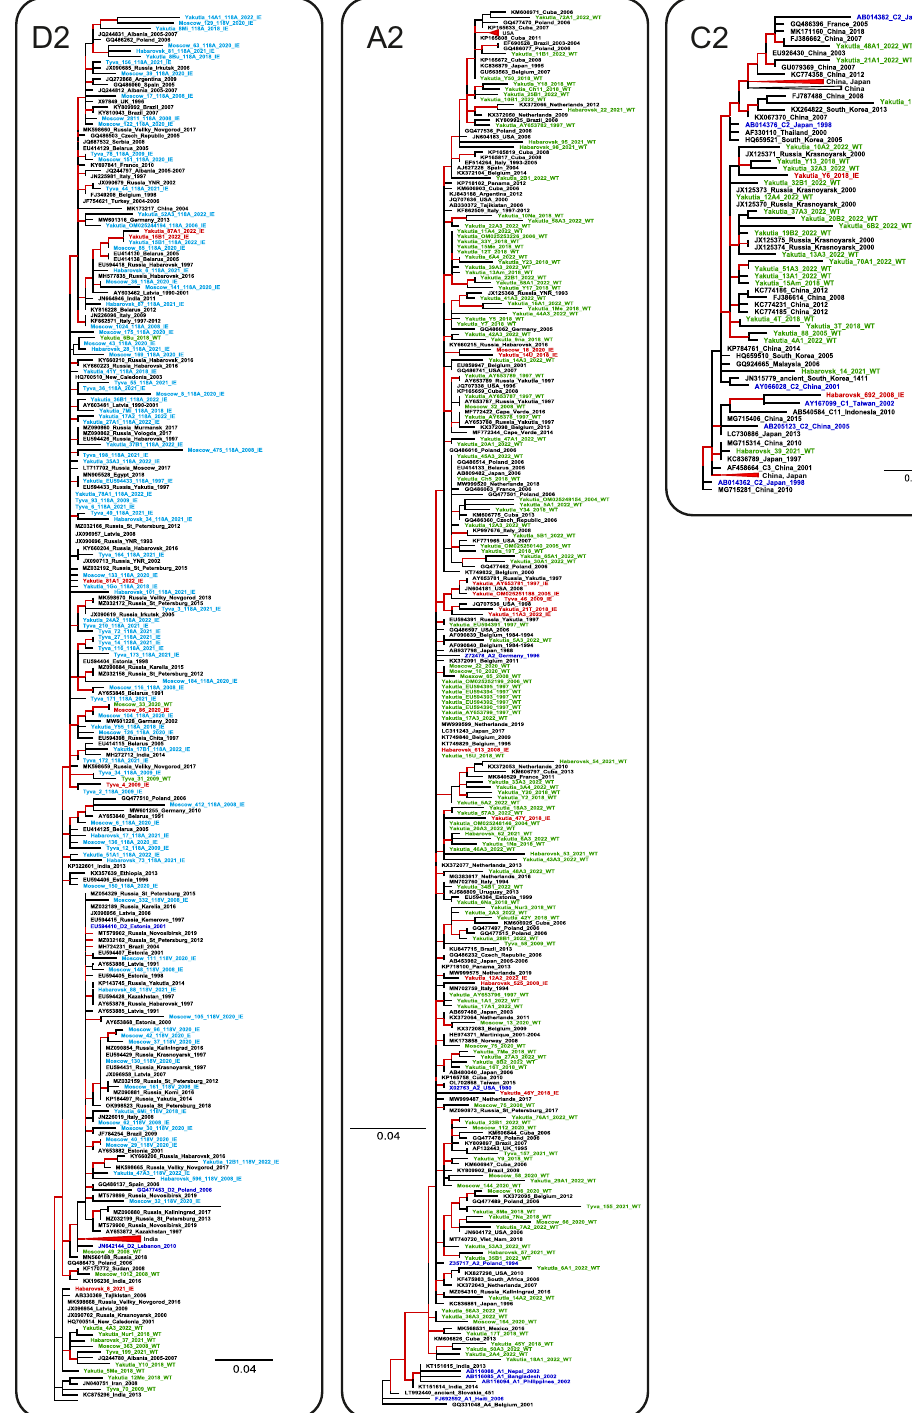
Figure 4. ML phylogenetic tree based on the 640 nt fragment of the HBV S-gene (nucleotide positions 157–796 by reference sequence NC_003977.2). Tree branches with a posterior probability of >90% are shown in red. Clusters containing sequences from this study and representing sub-genotypes D1, D2, D3, A2, and C2 are shown in separate panels. The GenBank database number, the HBV genotype, the country, and the year of isolation are indicated for each sequence. Sequences from this study are shown using the following colors and abbreviations: green (WT)—wild-type, red (IE)—immune-escape HBsAg variants with the exception of T118A/V, light blue (IE)—T118A/V variants, blue—reference sequences for HBV genotypes and